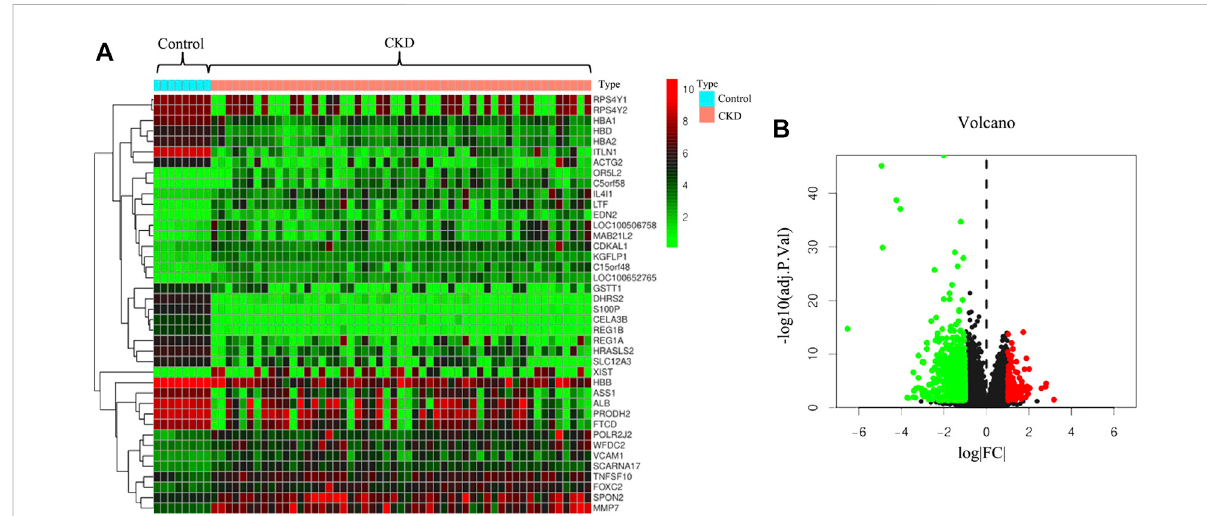
FIGURE 1 Prediction of differentially expressed genes between patients with chronic kidney disease (CKD) and healthy donors. (A) Heatmap of differentially expressed genes in human kidney tissues with or without CKD. (B) Volcano plot of distribution of differentially expressed genes.